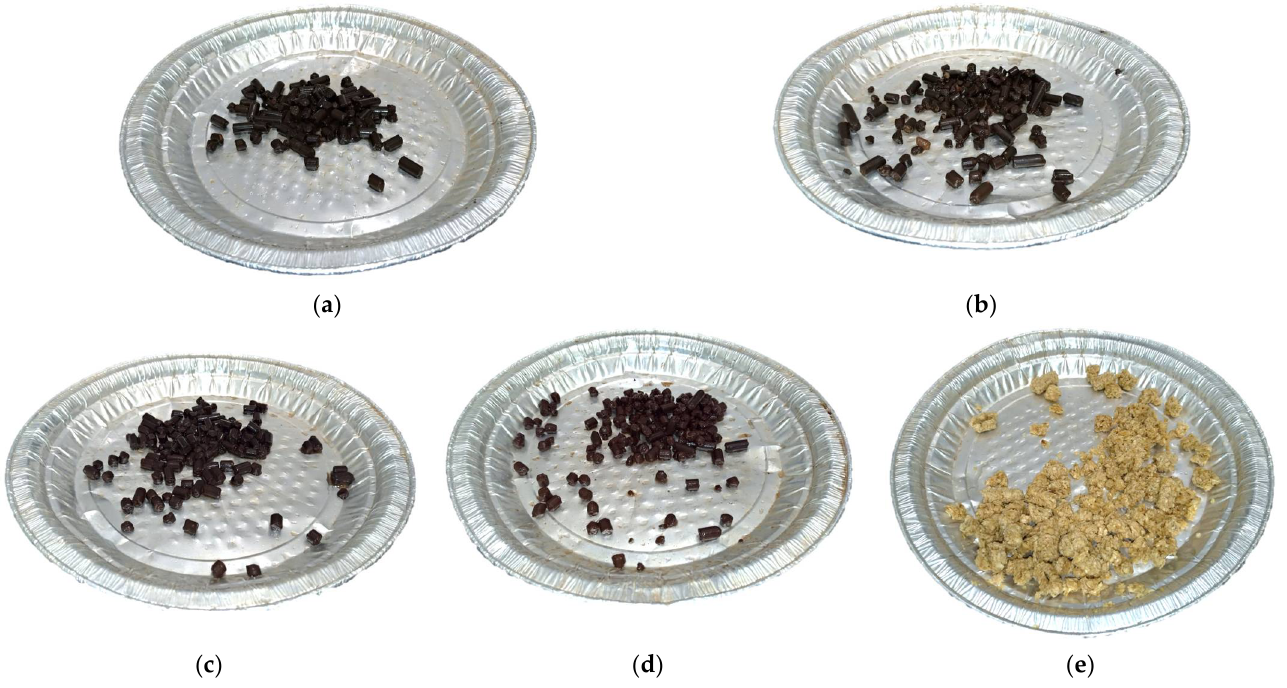
Figure 10. Picture of the poplar wood lignin pellets after 2 min submerged in water for pellets with an original moisture content of ( a ) 8.01 wt%, ( b ) 26.21 wt%, ( c ) 30.07 wt%, ( d ) 38.83 wt%, as well as softwood bark pellets ( e ) 6.57 wt%. Table 4. Scenario 1: mass of pellets before and after being immersed in water for 2 min as well as the percentage of water absorbed.